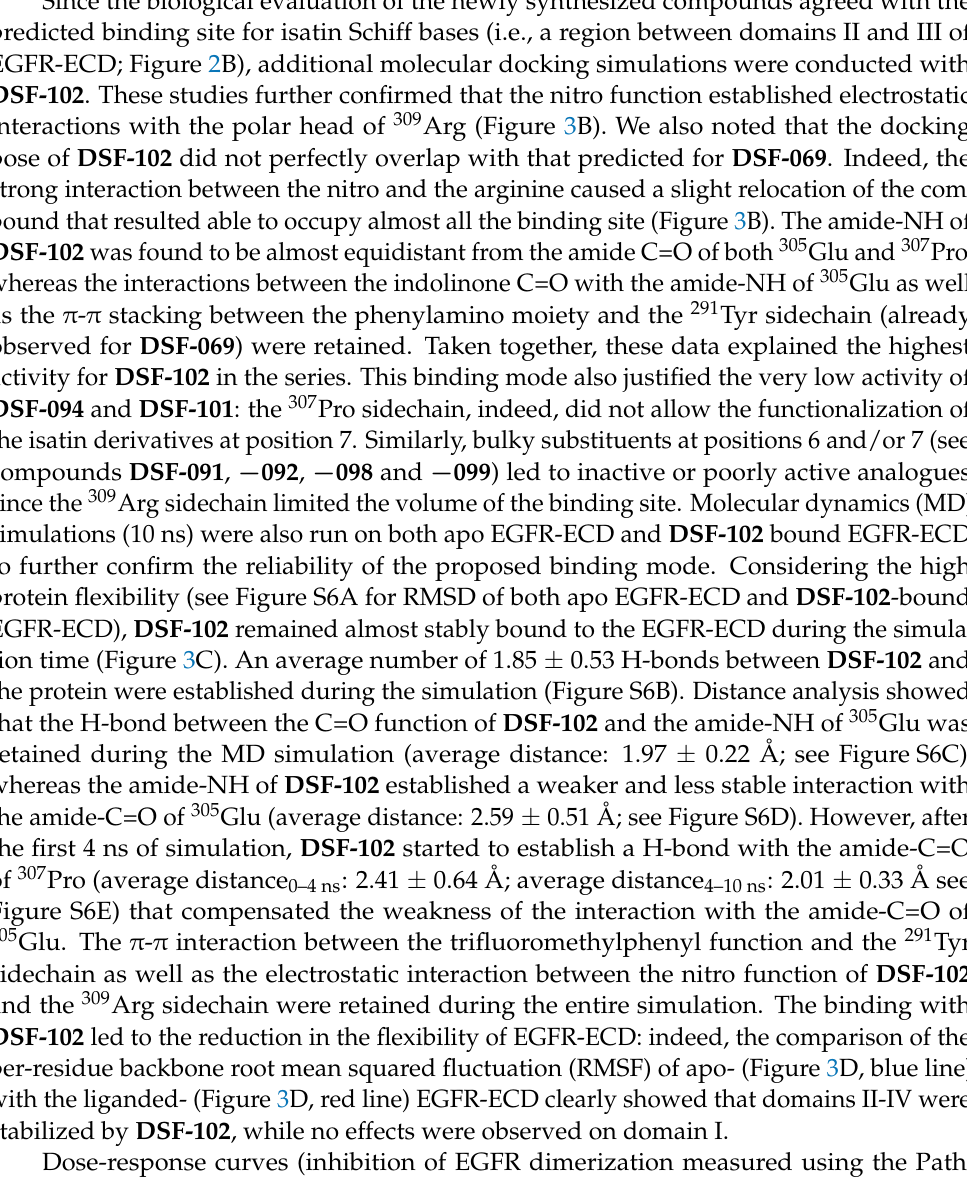
lines; π - π interaction are depicted as green dashed lines; electrostatic interactions are depicted as blue dashed lines. The binding mode of DSF-069 (light gray) is also reported to show how DSF-102 resulted slightly shifted with respect to the parent compound, thus leading to a higher complementarity with the binding pocket. ( C ) Root mean squared deviation (RMSD, Å) for DSF-102 during 10 ns of MD simulation. ( D ) Comparison of per-residue root mean squared fluctuation (RMSF, Å) obtained during 10 ns of MD simulation of apo EGFR-ECD (blue line) and DSF-102 bound EGFR-ECD (red line). ( E ) Residual catalytic activity (%) of the isolated kinase domain of EGFR upon treatment with DSF-102 . Please note that no inhibition was observed up to 100 µ M. ( F ) DSF-102 dependent inhibition of the binding between EGF and isolated EGFR-ECD as measured by SPR